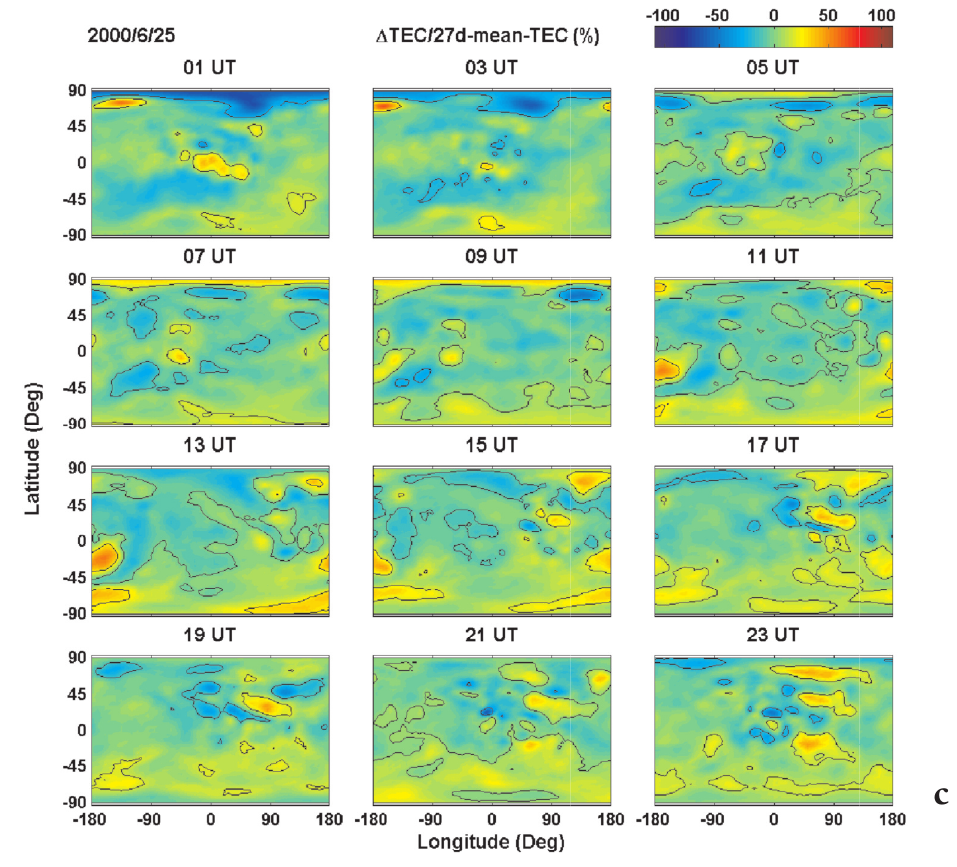
Figure 5c. See caption on previous